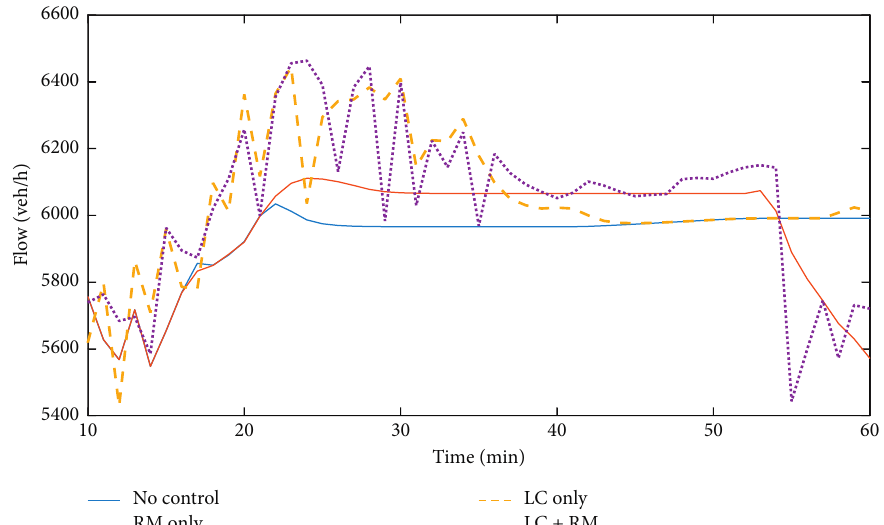
Figure 5: Flow exiting the